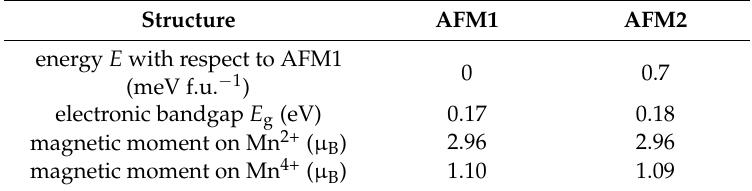
Table 4. Results of the LSDA calculations for magnetic structures AFM1 and AFM2